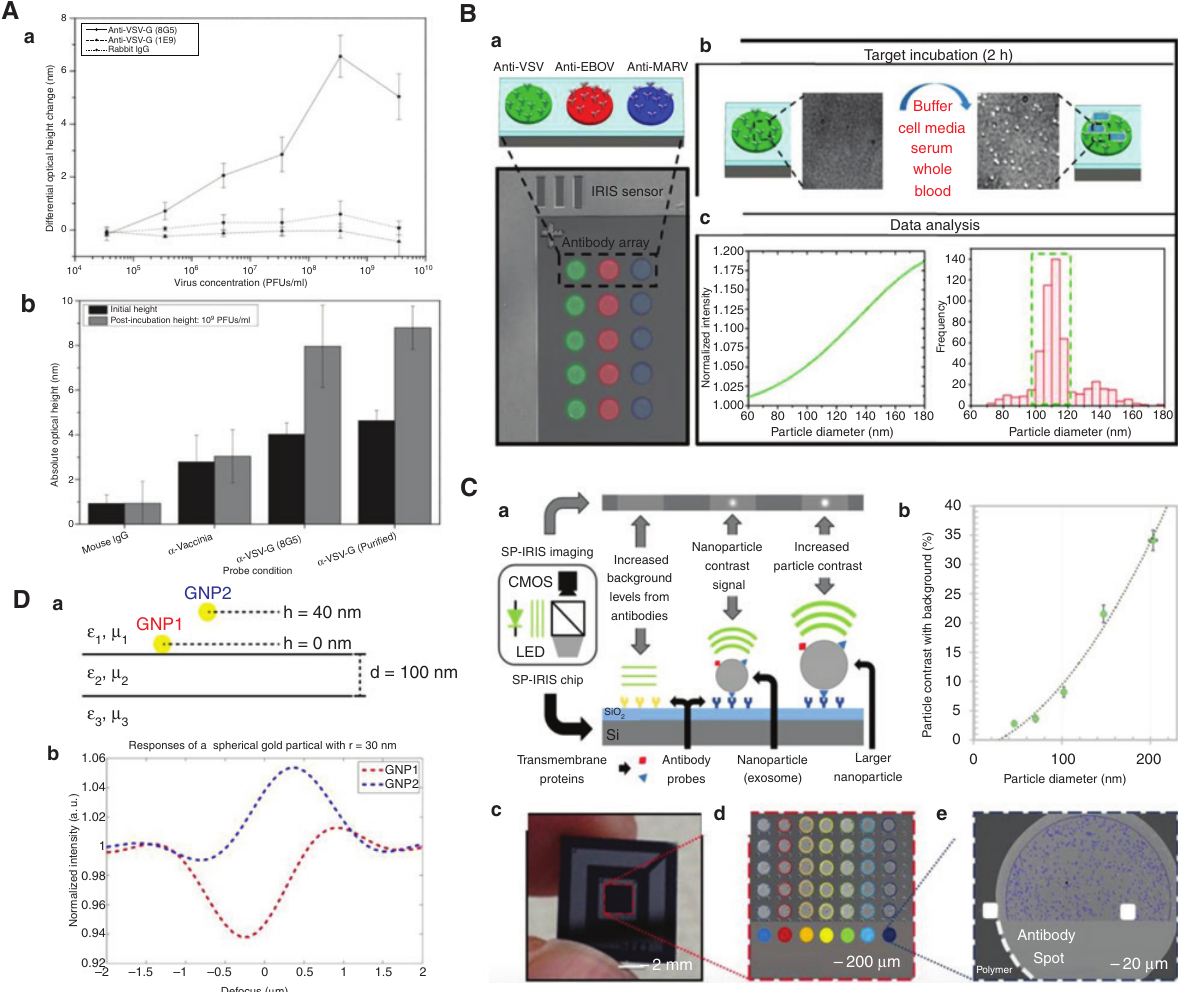
Figure 9: (A) (a) A calibration curve for wild-type VSV (8G5) sample tested with IRIS platform. Corresponding height changes upon specific virion particle binding is shown. Greater binding indicates the greater affinity to immobilized antibody on the sensor. (b) Specific binding and low non-specific binding are shown in the results of pre- and post-incubations with the virions. Adapted from [87]. (B) (a) A SP-IRIS microarray configuration with immobilized antibody spots in green, red, and blue for anti-VSV, anti-EBOV, and anti-MARV probes, respec- tively. (b) Data acquisition and analysis for virus identification using SP-IRIS. Captured VSV particles can be seen on anti-VSV antibody spotted sensor surface (right) when compared to pre-incubation image (left). (c) The model used for determining the size of each particle within the spot (left) and a size distribution of particles identified on the spot of the image (right). The selected region on the plot represents expected sizes of VSV. Adapted from [88] (Reprinted with permission from [88]. Copyright 2014 American Chemical Society). (C) (a) Sche- matic representation of the SP-IRIS detection principle (b) SP-IRIS signal for polystyrene nanoparticles with a diameter from 50 to 200 nm used to be reference for exosomes. (c) An image of the SP-IRIS chip. (d) IRIS image of immobilized antibody surface probes. (e) SP-IRIS image of captured particles on the spot, which are detected via NVDX analysis. Adapted from [38]. (D) SP-IRIS measurement of spherical gold nanoparticles (r = 30 nm) at (a) h = 0 nm (GNP1) and h = 40 nm (GNP2), and (b) their interferometric responses (GNP1 shown in red, and GNP2 shown in blue). Adapted from